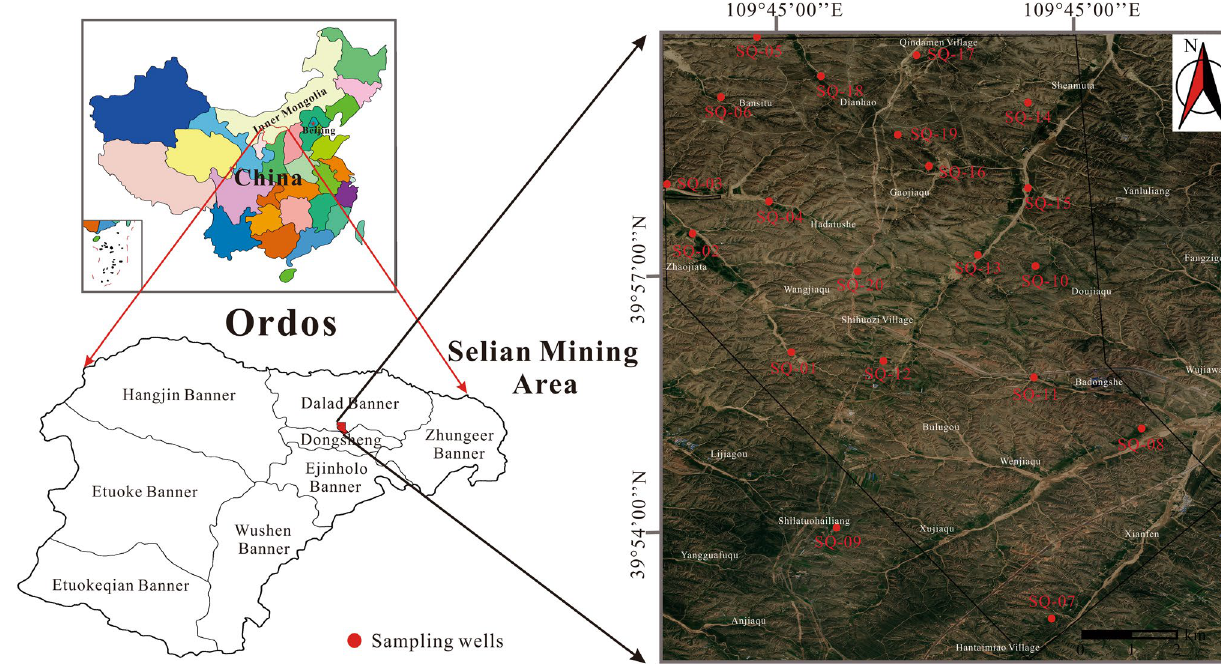
Fig. 1 Location of the study area (modified after: Feng et al.